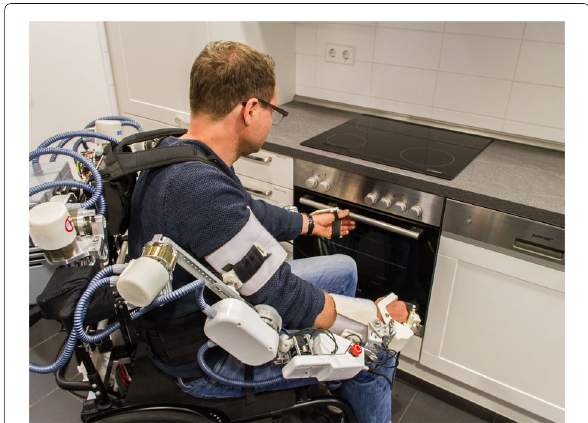
Fig. 3 An upper-body exoskeleton integrated into a wheel chair can support patients in doing everyday tasks as well as the overall rehabilitation process. (Copyright: DFKI